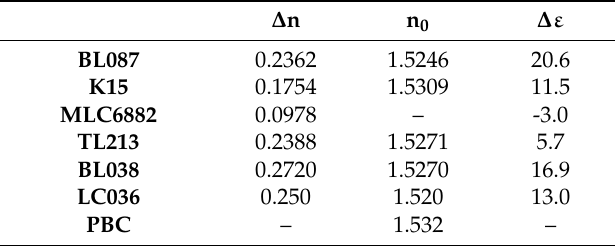
Table 1. Properties of liquid crystals (LC)